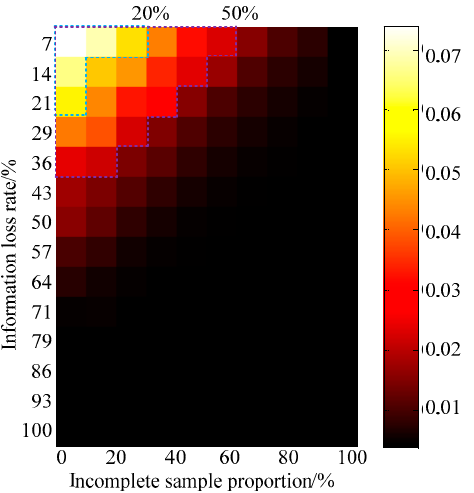
Figure 5. Deviation rate of generative adversarial networks based heterogeneous data integration (GANs-HDI) algorithm on heterogeneous datasets for intelligent power distribution and utilization.